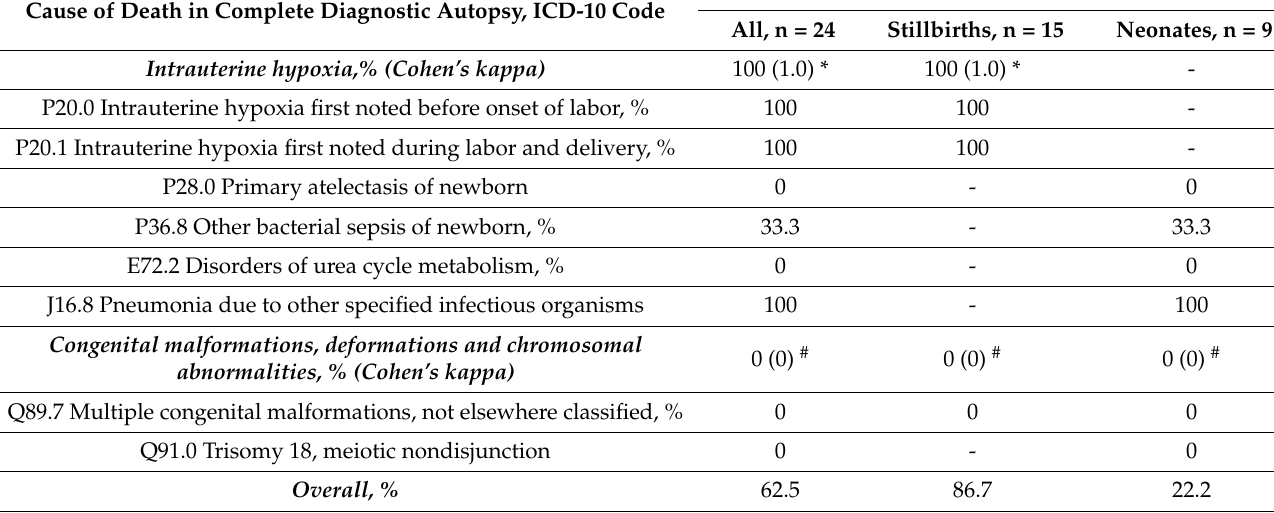
Table 4. Concordance rates of causes of deaths between complete diagnostic autopsy and Minimally Invasive Tissue Sampling (MITS) based on histological investigations among all, stillbirths and neonates. Cause of Death in Complete Diagnostic Autopsy, ICD-10